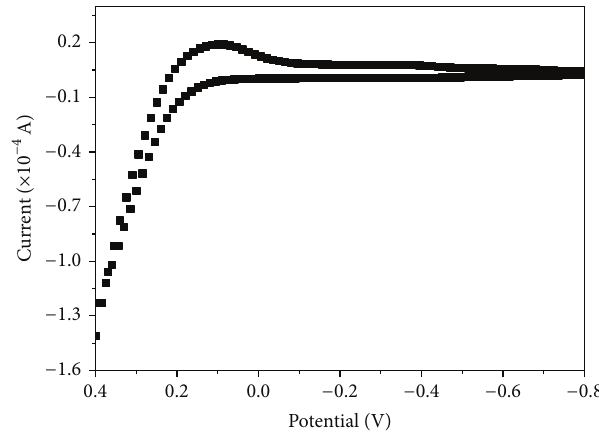
Figure 2: Cyclic voltammetry curve of the 0.3 M KI in ethylene